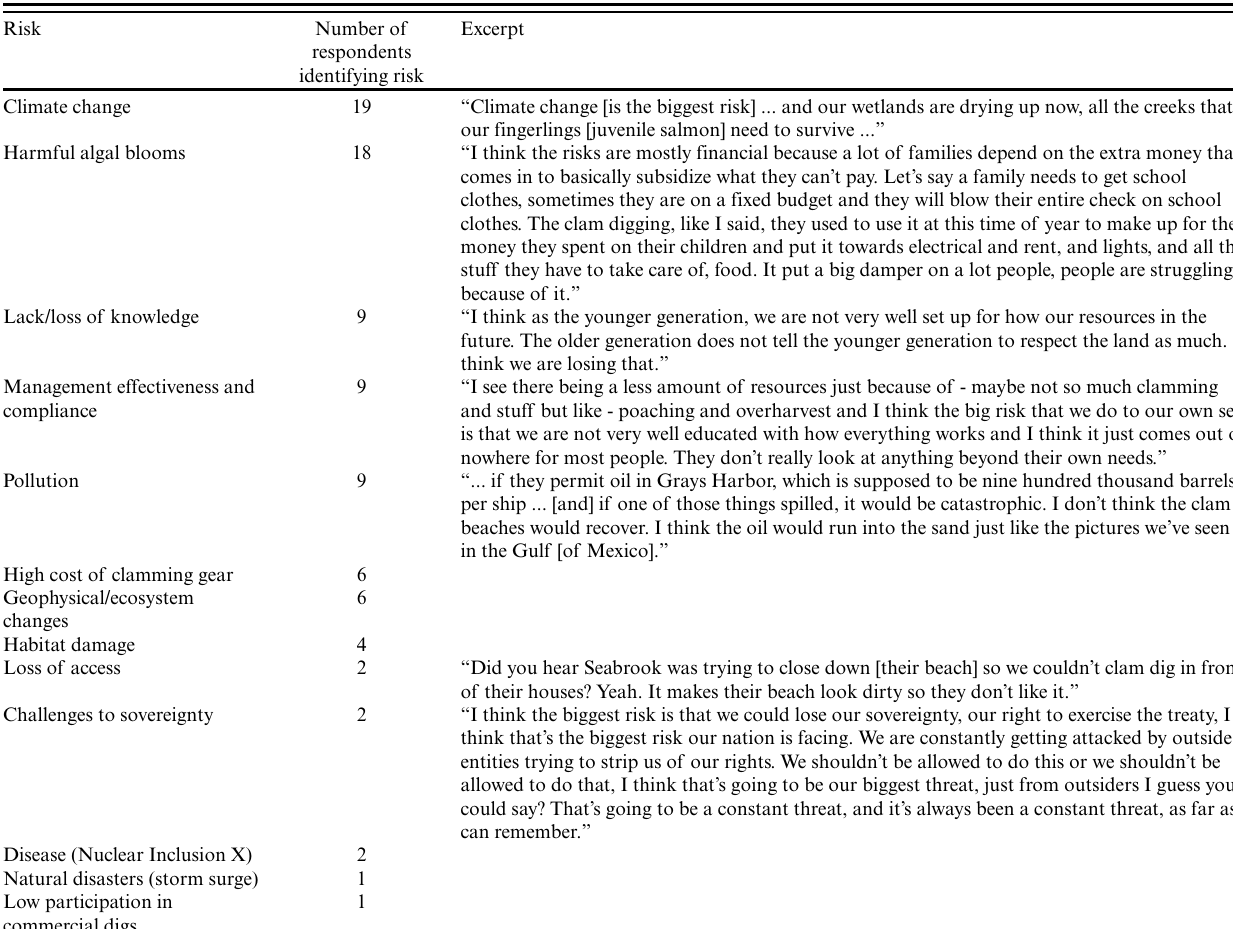
Table 1 . Perceived risks identified by interviews. List of general risks, number of respondents ( n = 30) who identified each risk, and some excerpts from interviews to demonstrate how the Quinault perceive these